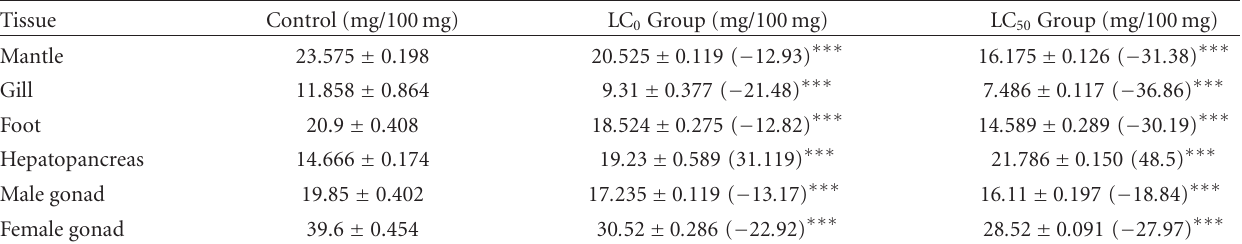
Table 1: Cypermethrin induced alterations in the total glycogen content of K. opima after acute exposure. (Results expressed in mg/100mg dry wt.